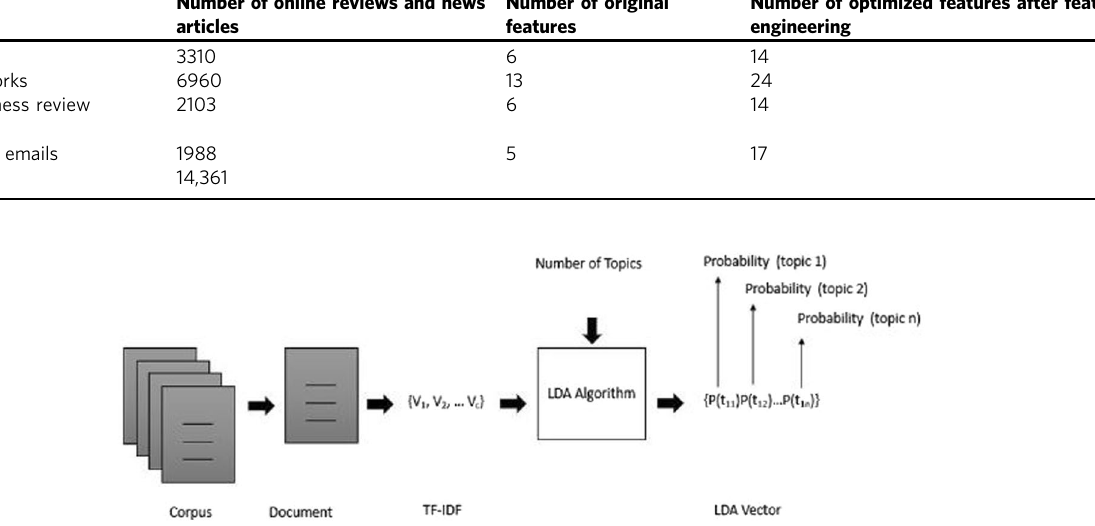
Fig. 3 LDA model (Carrera-Trejo et al., 2015). In the LDA, each document is represented based on its probability of belonging to a topic. Probability distributions are generated based on n -grams (or syntactic n -grams) of the corpus. Topics determine the number of partitions in